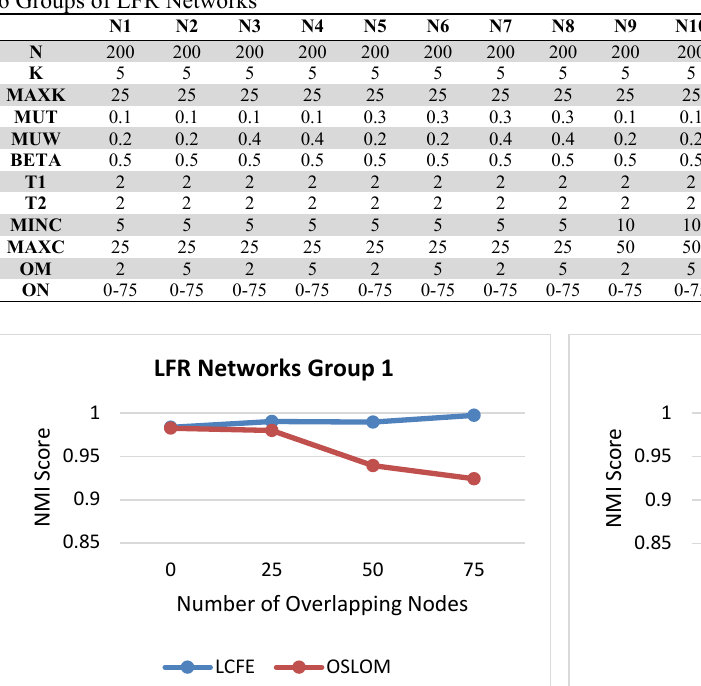
Fig. 4. NMI score comparison for LCFE and OSLOM for second group of LFR Networks with number of overlapping nodes ranging from 0 to 75